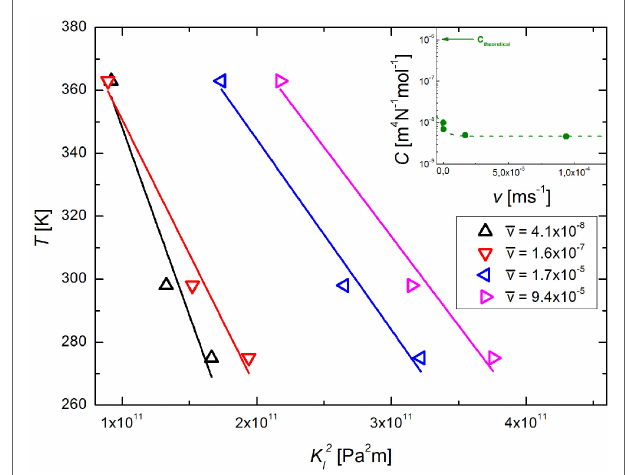
FIGURE 3 | Determination of molar strain energy in subcritical crack growth. The temperature is plotted as a function of the square of the stress intensity factor at the crack tip for constant crack velocity. A linear fit (straight lines) yields the C -parameter. The inset shows the apparent dependence of C on crack velocity. Here, the dotted line is just a guide to the eye.